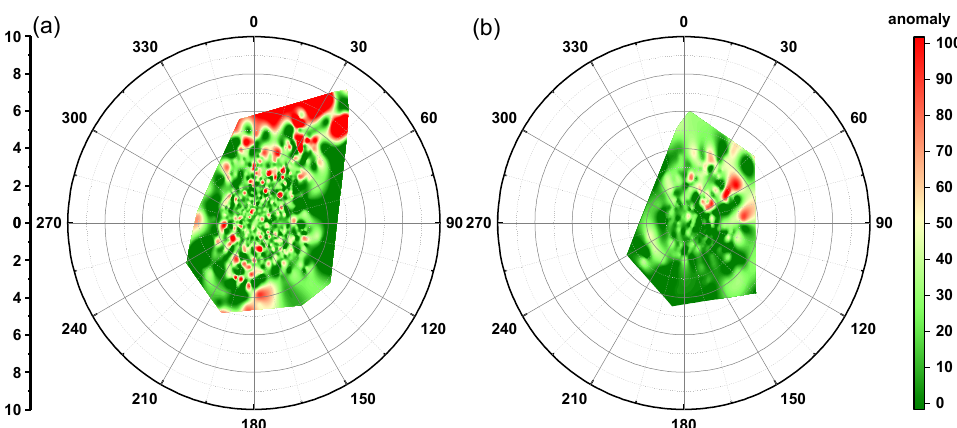
Figure 5. Polar plots of hourly variations in wind speed (round radius, unit: m/s) and direction (angles) to the surface PM 2.5 concentration anomaly (color contours, unit: µ g/m 3 ) of the first eigenvectors. ( a ) WH in 2016–2019 and ( b ) WH in 2020.